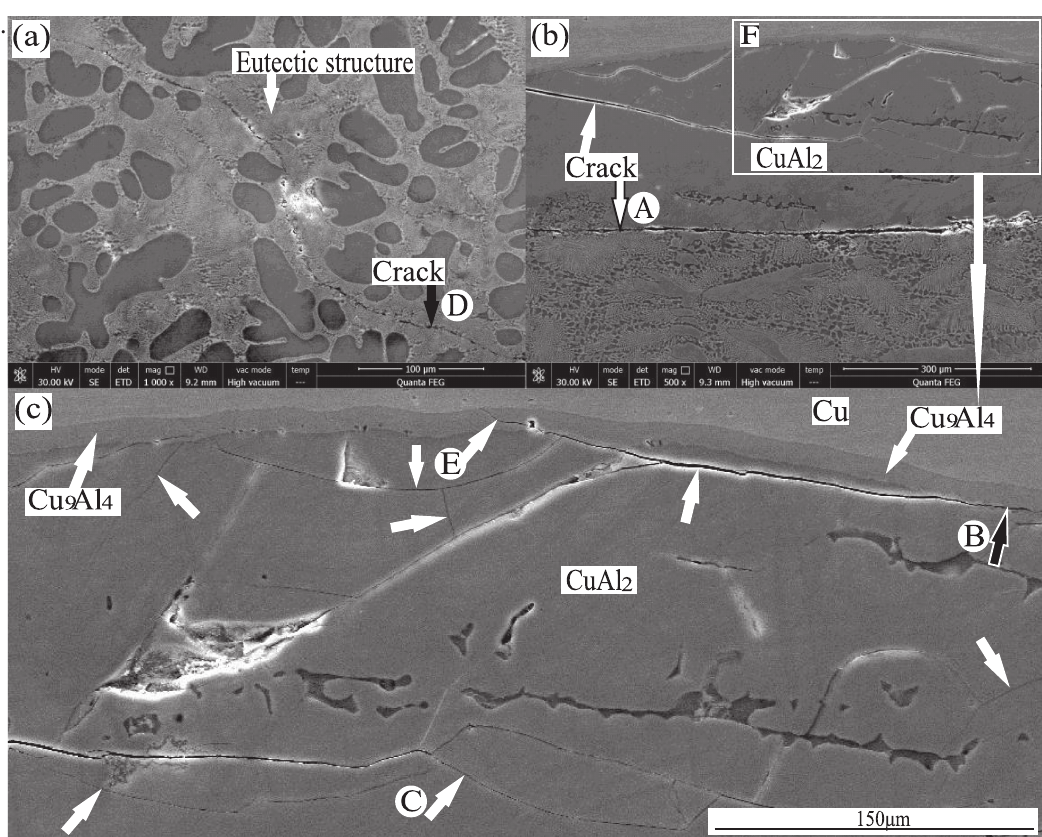
Figure 7: Cracks in the transition layer under pouring at 830°C, holding for 110 s and jet air cooling.